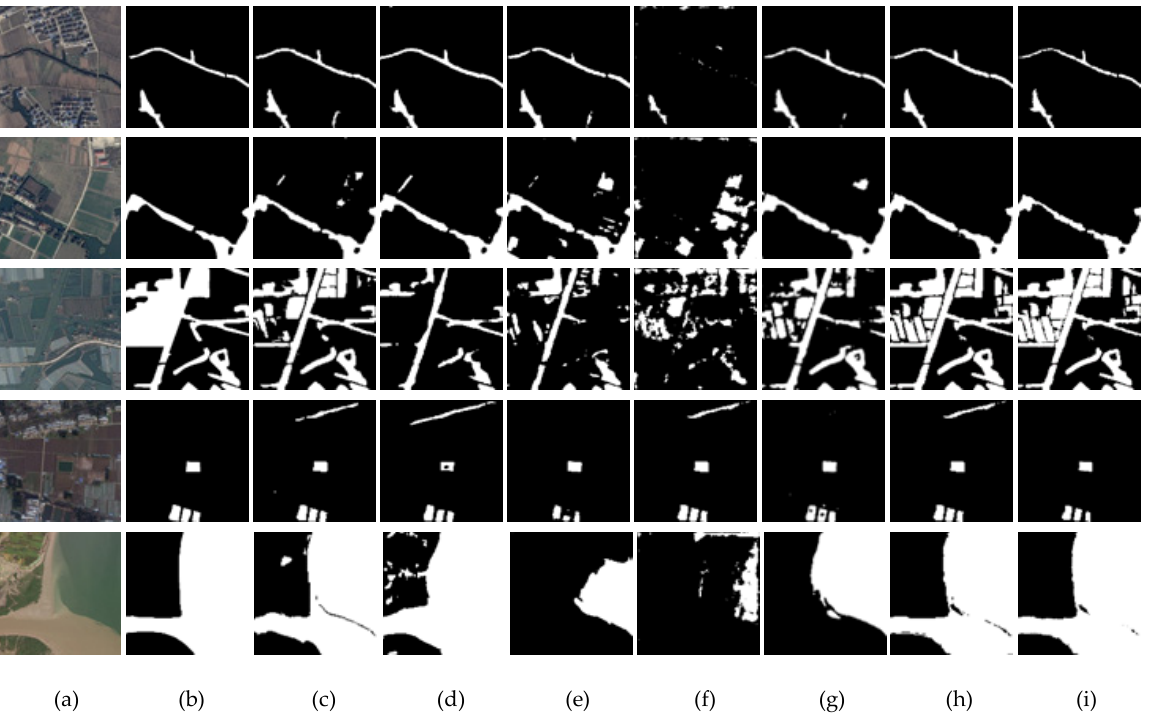
Figure 5. Qualitative comparisons with the other state-of-the-art methods in the source domain. ( a ) Image; ( b ) Ground-truth; ( c ) HRnet V2; ( d ) Bisenet; ( e ) U-Net; ( f ) DFAnet; ( g ) DeepLab V3+; ( h ) SFnet; ( i ) SFnet + CRF.